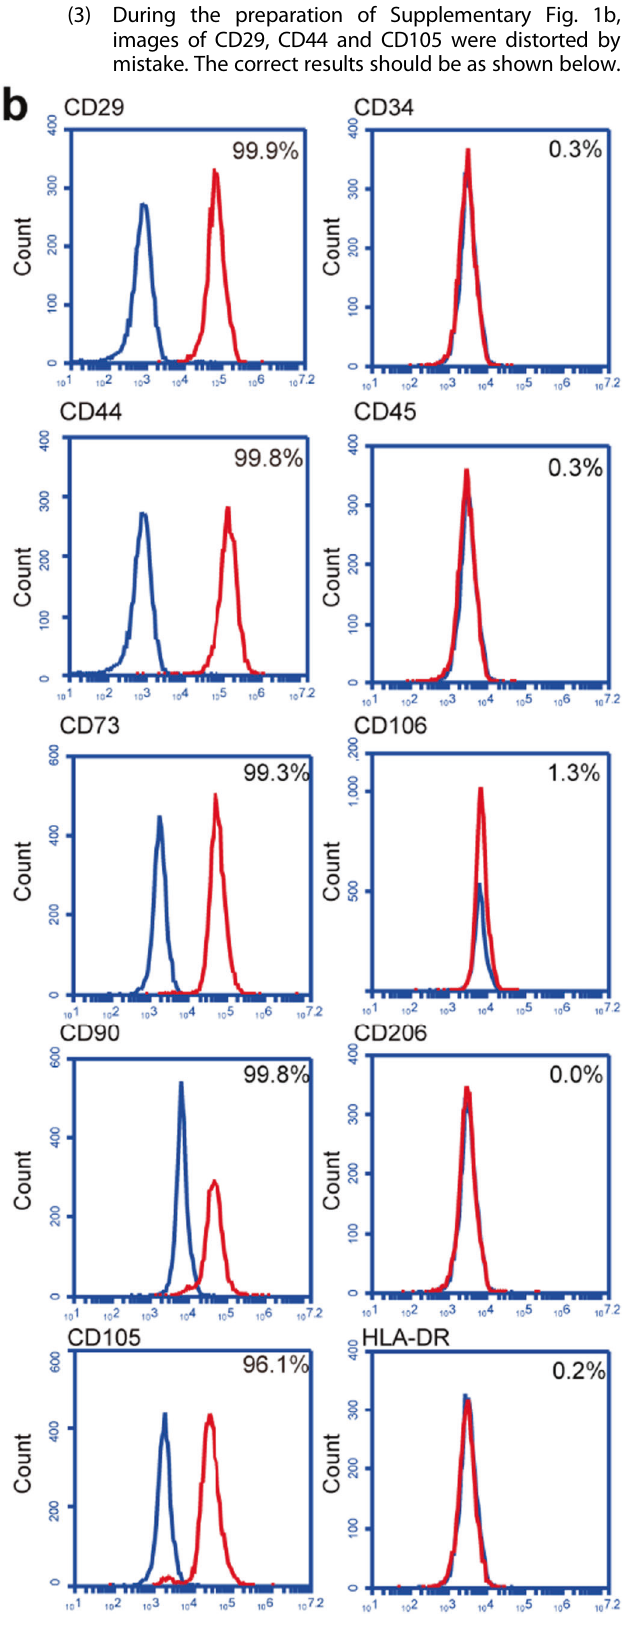
Fig. S1b Flow cytometry analysis found MSC markers CD29, CD44, CD73, CD90, CD105 are positive, and CD34, CD45, CD106, CD206, HLA-DR are